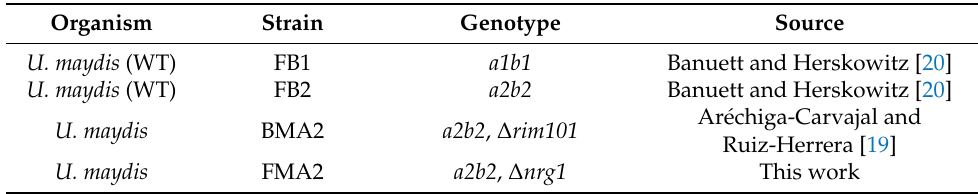
Table 1. Strains of Ustilago maydis used in this